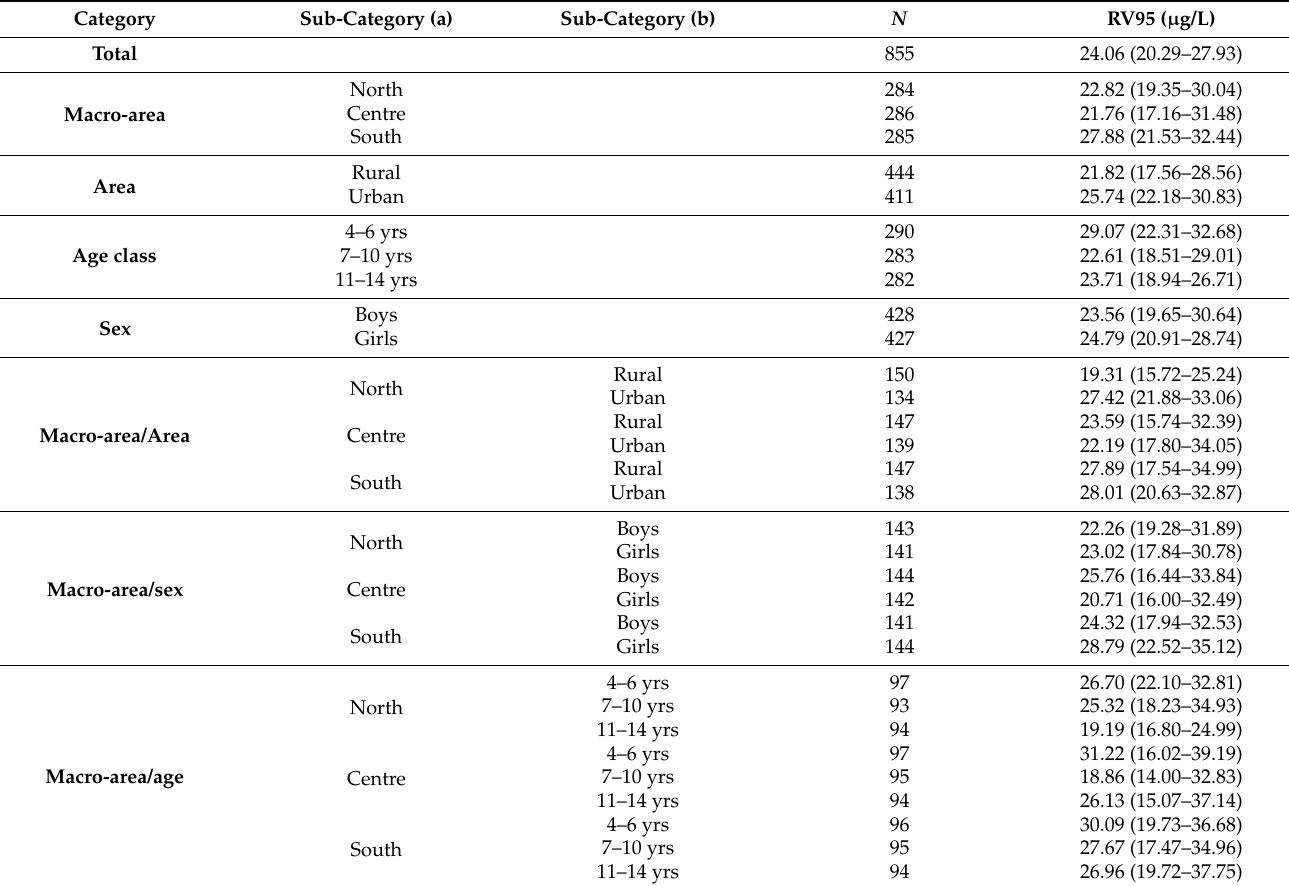
Table 4. Reference values (RV95, P95 (95% CI)) for BPA in urine of Italian children (4–14 years old) according to sex and to the residing area/macro-area, excluding subjects with daily intake ≥ 1 µ g//kg bw per day.